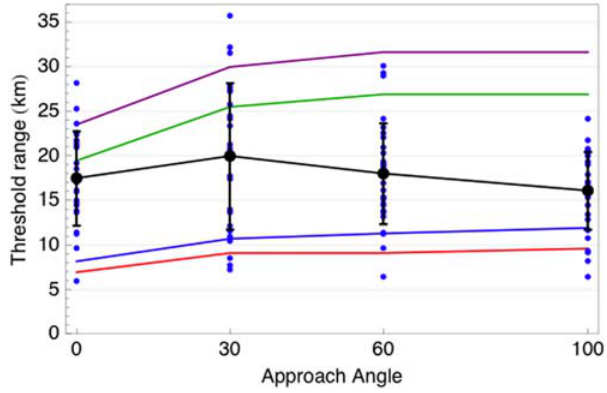
Figure 18. Threshold distance for a DC-3 aircraft at four viewing angles. The points are data from Howell [5], and the black lines show mean and plus and minus one standard deviation. The red curve is the SSO prediction for a well-lit craft and the green curve is SSO prediction for a dark silhouette. The blue and purple curves are comparable predictions for a highly sensitive observer